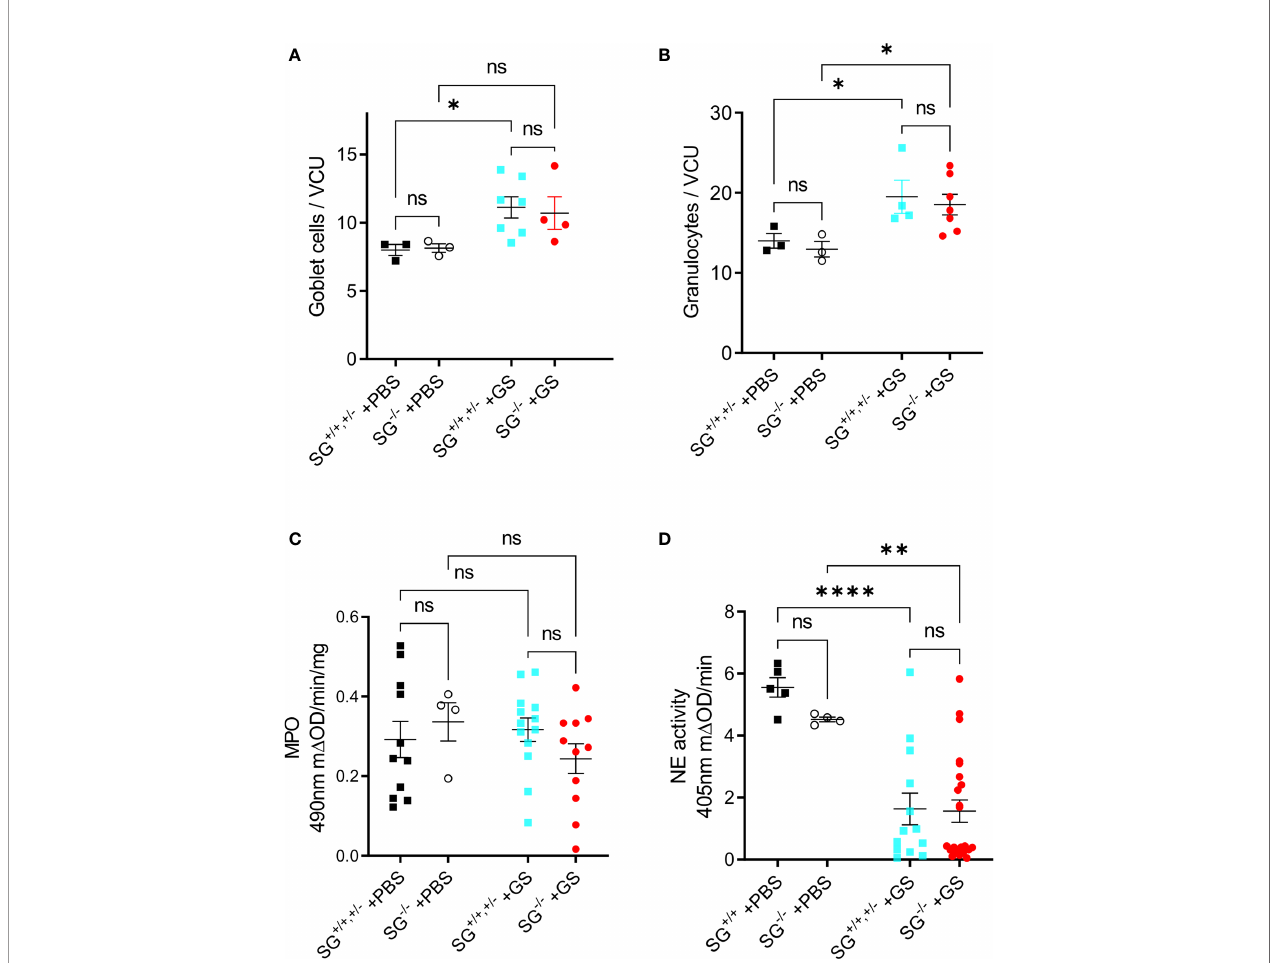
FIGURE 2 | Infection with Giardia intestinalis increases goblet cell and granulocyte counts in the small intestine but inhibits neutrophil elastase (NE) activity. (A) Goblet cells and (B) granulocytes were counted per villi crypt unit (VCU) on H&E-stained sections from PBS-challenged and Giardia-infected mice. (C) Intestinal MPO activity (substrate o-phenylenedamine) and (D) neutrophil elastase. (NE) activity (substrateL-1770) in PBS-challenged and Giardia-infected SG +/+ and SG -/- littermate mice. ns, non-signi fi cant, P values * <0.05, ** <0.01, ***